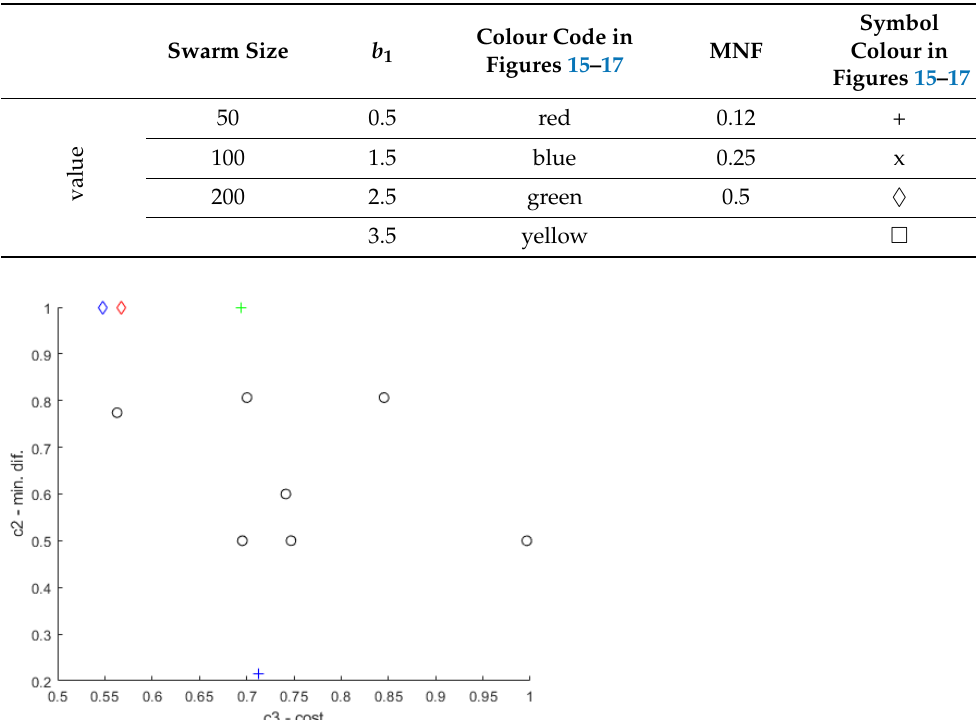
Table 7. PSO parameters and colour/shape codes for figures.